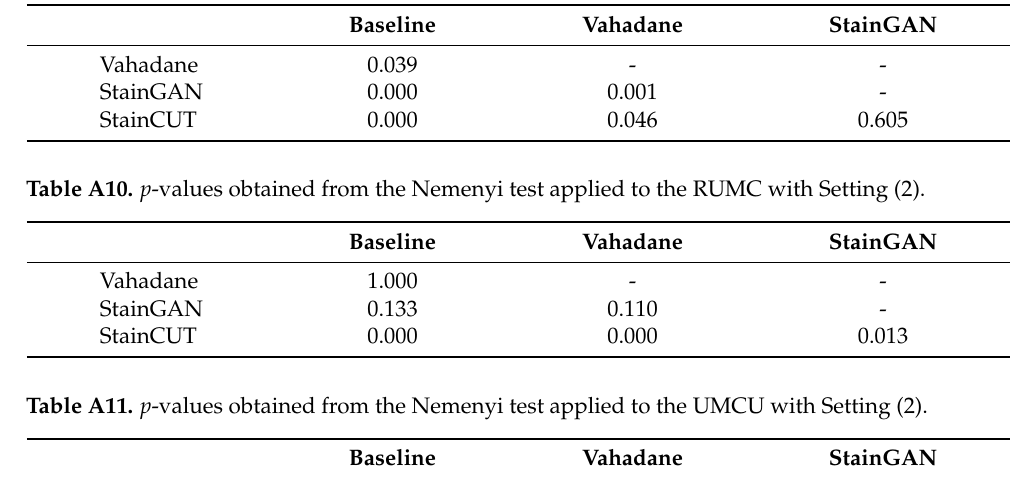
Table A9. p -values obtained from the Nemenyi test applied to the UMCU with Setting (1).